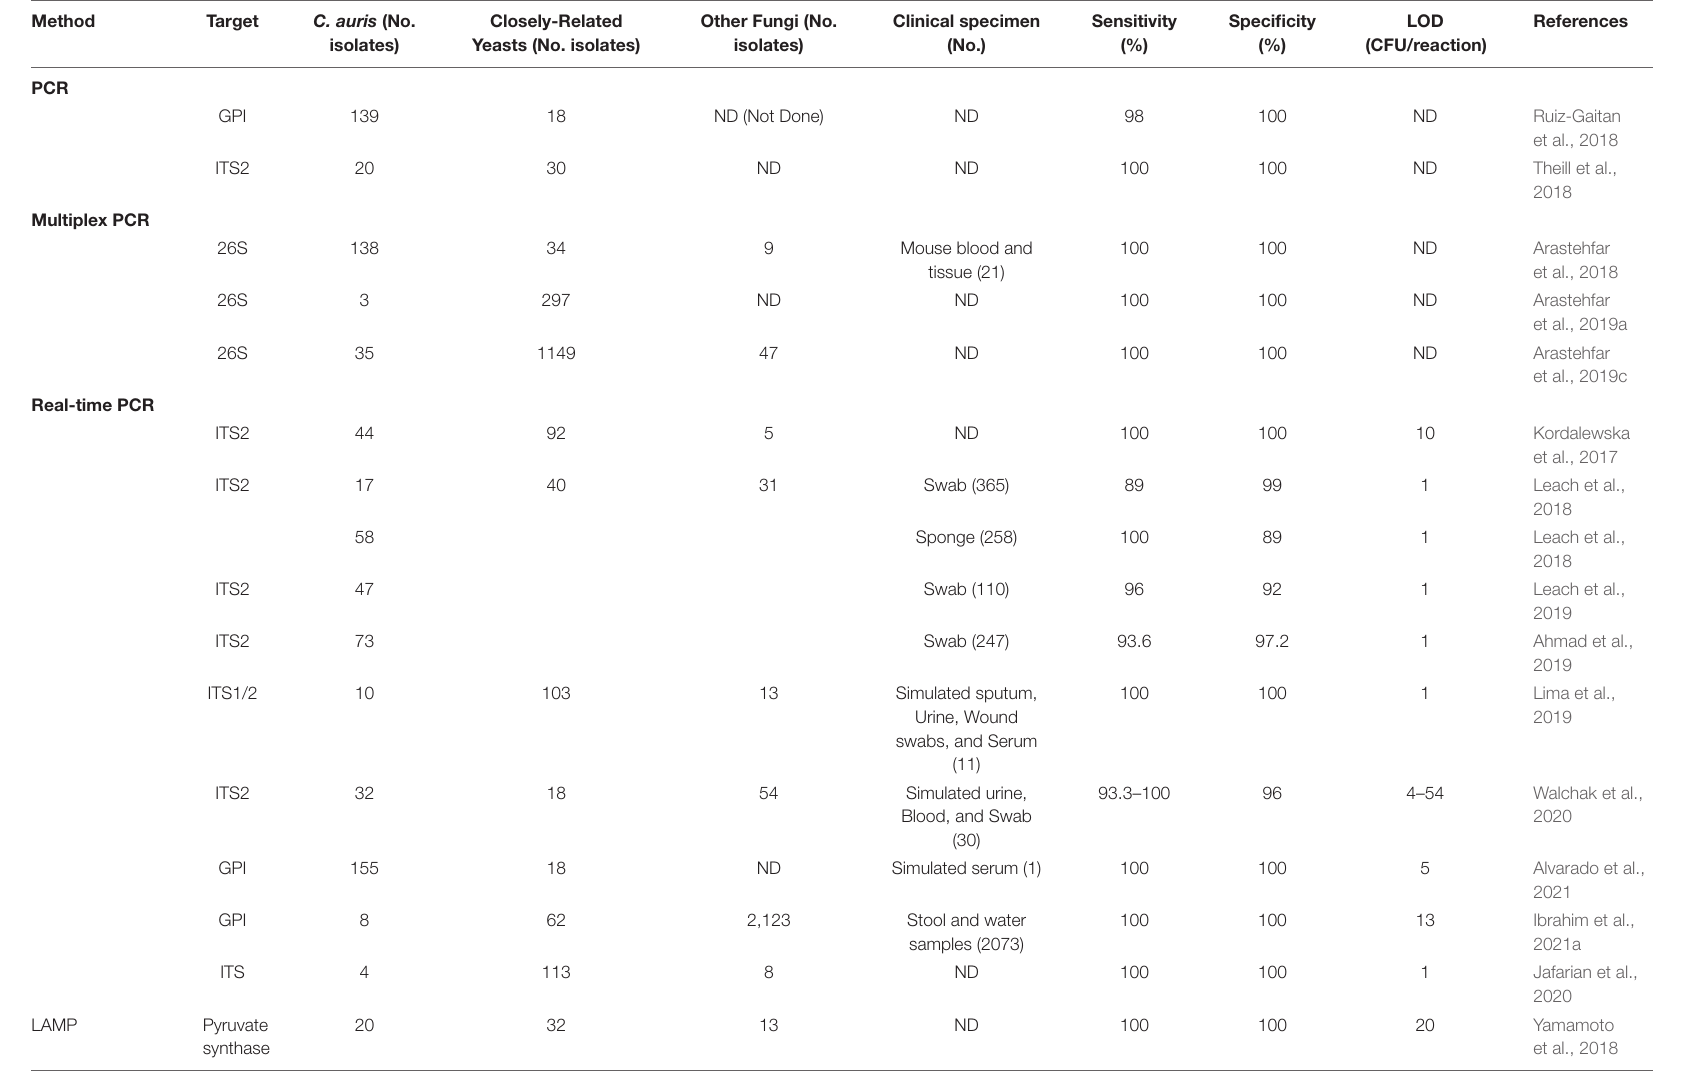
TABLE 1 | Candida auris culture-independent DNA-based identification and confirmation methods.